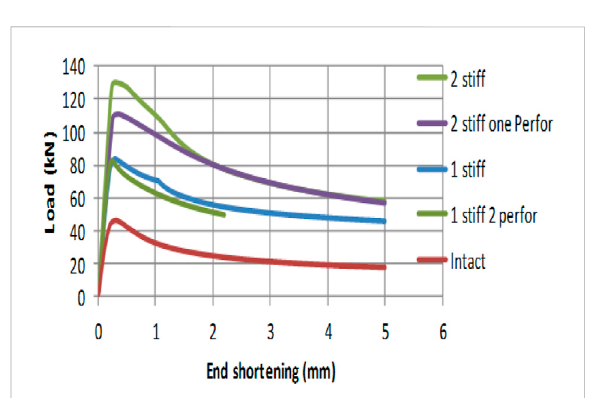
FIGURE 11 Load end shortening relationship for stiffened and stiffened perforated compared with the intact plates.